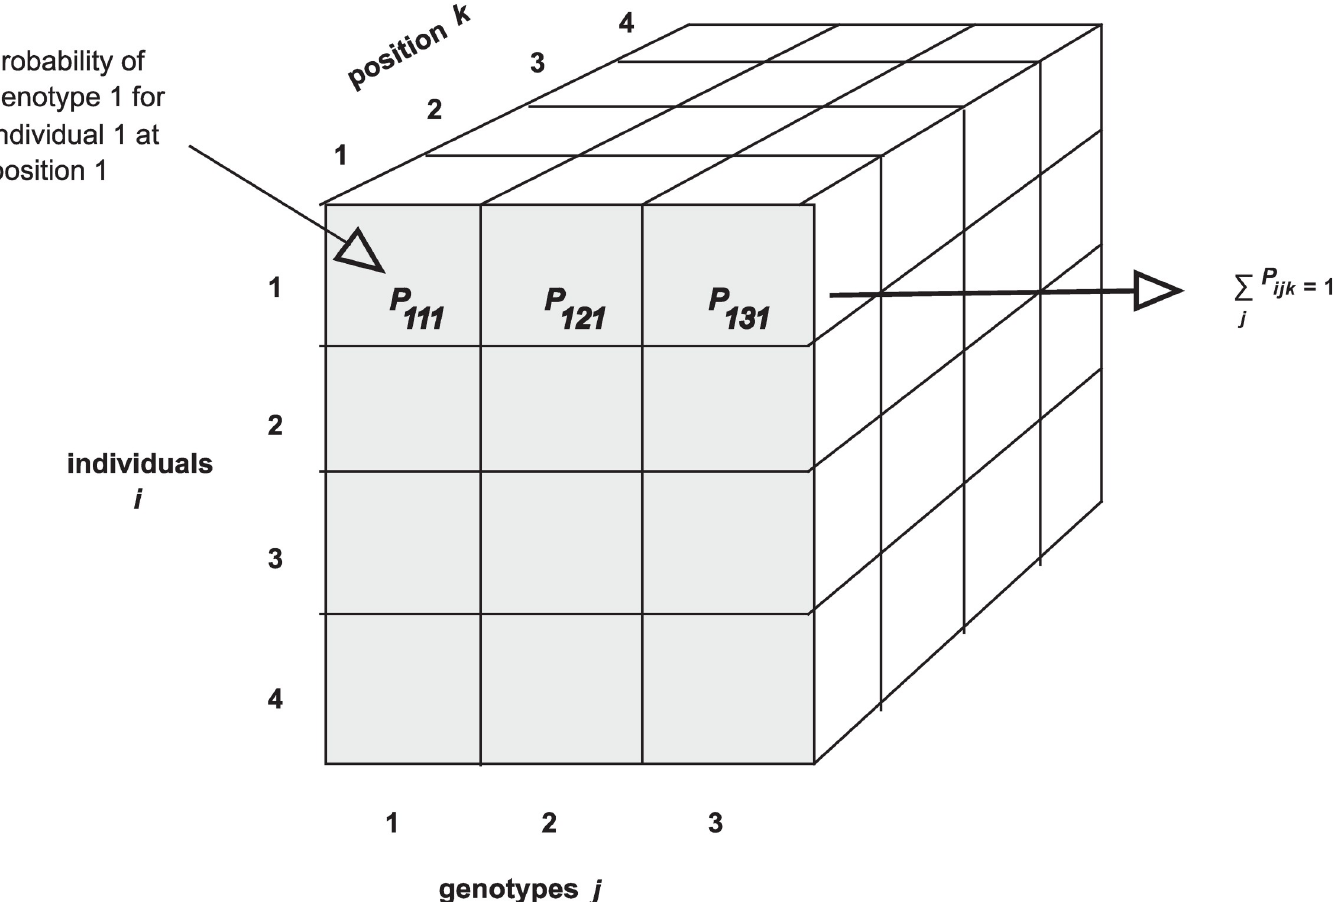
Fig 2. Simple graphics can make complex concepts more concrete and understandable. This example from Quantitative Trait Mapping illustrates a three-dimensional array of genotype probabilities across individuals, genotypes, and genomic positions. Each cell in the three-dimensional array represents a specific genotype in one individual at a genomic location. Uncertainty about genotypes is captured by probabilities that must sum to one at each location for each